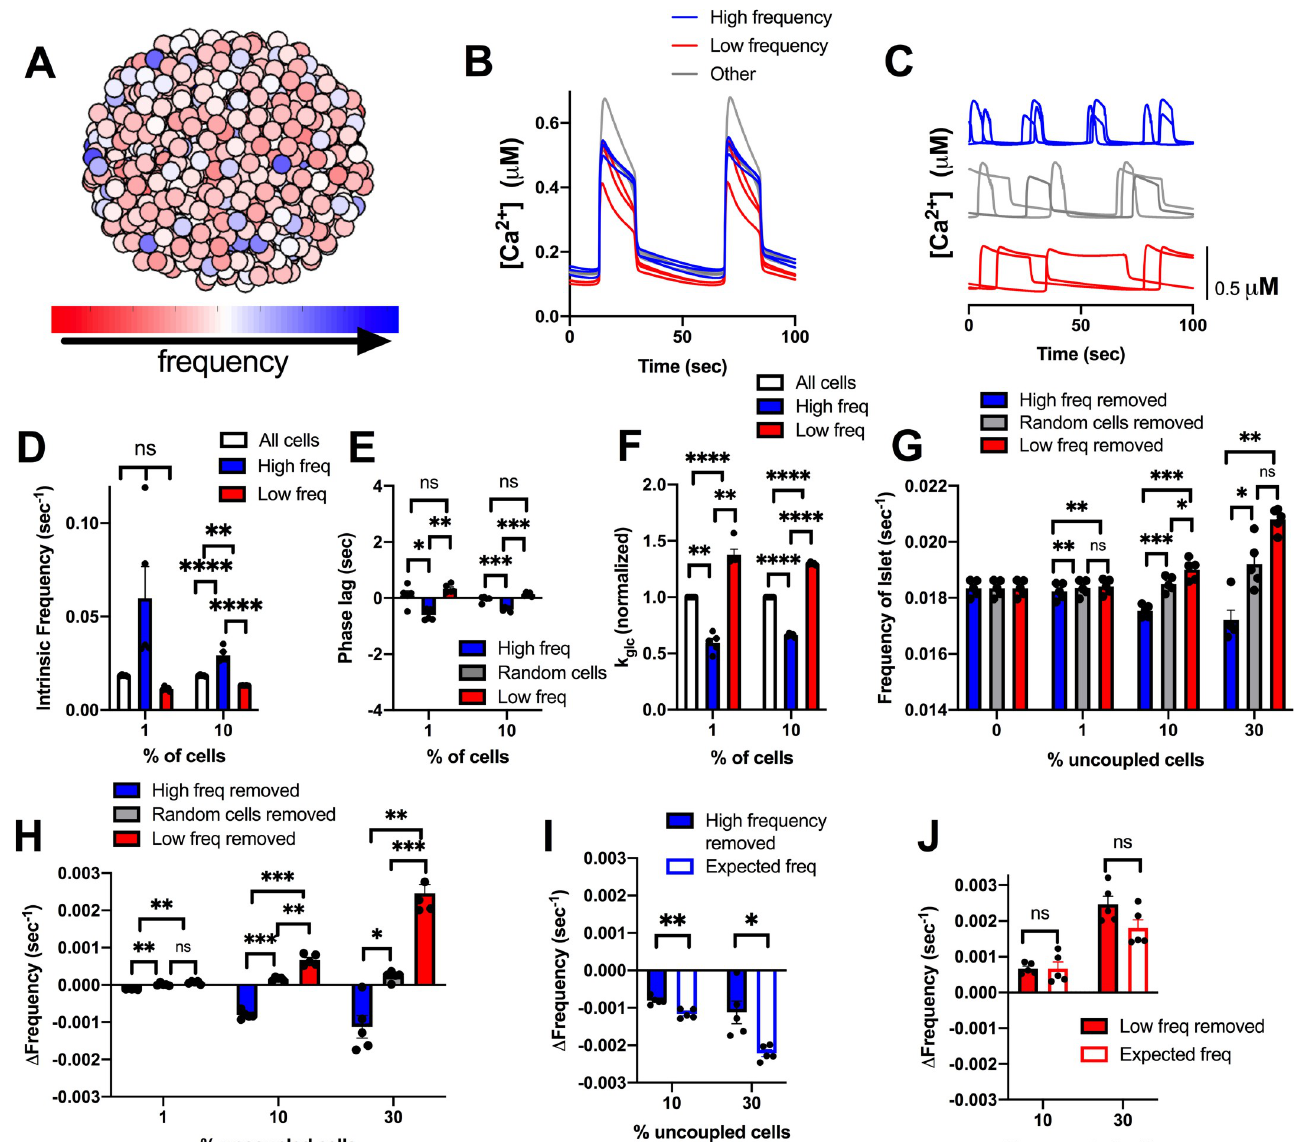
Fig 5. Simulations predicting how intrinsic frequency of cells contributes to islet frequency. A). Schematic of frequency across simulated islet with 25% variation in GK activity. B). Representative time courses of [Ca 2+ ] for 9 cells in simulated islet in A in a simulation with full (120pS) coupling conductance. Blue traces are high frequency cells, Grey are cells with frequency near average frequency, red traces are low frequency cells. C). Same cells as in B but showing [Ca 2+ ] time courses from an uncoupled simulation (0pS coupling conductance). D). Average intrinsic oscillation frequencies of all cells, top 1% or 10% of high frequency cells, or low frequency cells when re-simulated in the absence of gap junction coupling. E). Phase lag from islet average of top 1% or 10% of low frequency, high frequency, or random cells. F). Average k glc from all cells, high frequency cells, or low frequency cells across simulated islet (normalized to average k glc ). G). Average frequency of islet when indicated populations of cells are removed from the simulated islet. H). Change in frequency of islet with indicated populations removed with respect to control islet with all cells present. I). Change in frequency when high frequency cells are removed compared to average oscillation frequency of remaining cells that indicates the expected oscillation frequency. J). Same as I. but for simulations where low frequency cells are removed. Error bars are mean ± s.e.m. Repeated measures one-way ANOVA with Tukey post-hoc analysis was performed for simulations in D-H and a Student’s paired t-test was performed for I and J to test for significance. Significance values: ns indicates not significant (p > .05), � indicates significant difference (p < .05), �� indicates significant difference (p < .01), ��� indicates significant difference (p < .001), ���� indicates significant difference (p < .0001). Data representative of 5 simulations with differing random number seeds. Random removal of cells across the islet was used for all simulations where random cells removed is indicated.